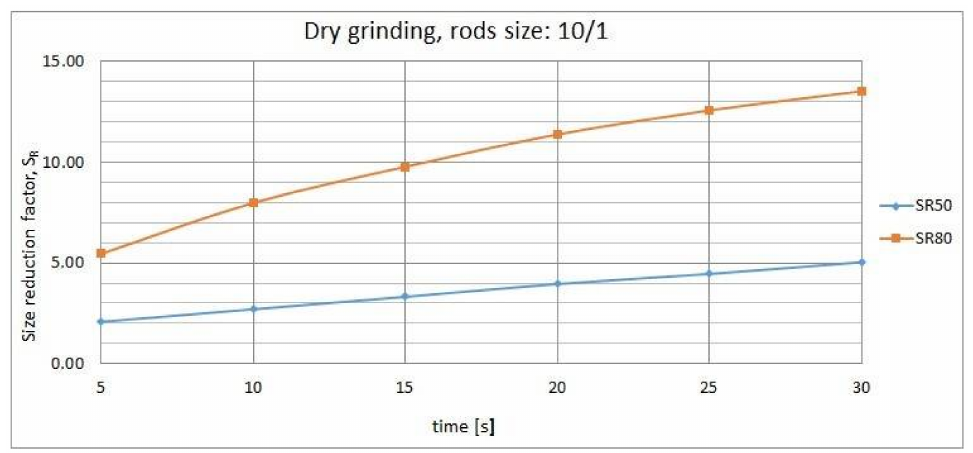
Figure 11. Comparison of S R factors for dry grinding with 10/1 rods. Table 3. Comparison of grinding effectiveness factors for dry grinding with 10/1